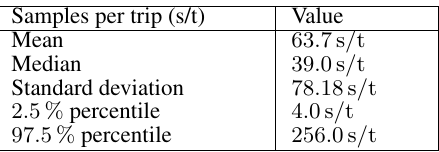
Table 4. Statistical details of the samples per trip.